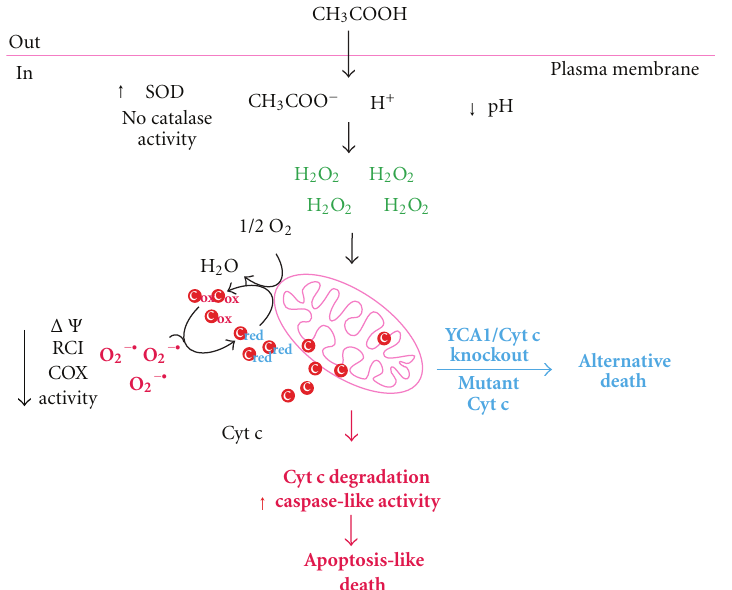
Figure 1: AA-PCD pathways. Acetic acid enters in yeast cells and dissociates into acetate and protons causing intracellular acidification. H 2 O 2 accumulates, SOD activity increases, while catalase activity is undetectable. En route to AA-PCD, cyt c is released and works as an electron donor (c red ) to mitochondrial respiratory chain and as superoxide anion (O 2 − • ) scavenger (c ox ). In a late phase, cyt c is degraded by unidentified proteases. Mitochondrial functions progressively decline with decrease in mitochondrial membrane potential ( ΔΨ ), respiratory control index (RCI) and COX activity. Caspase-like activity increases in a late phase (red lines). Alternative programmed cell death is induced by acetic acid in YCA1 and/or cyt c knockout cells or in mutant cyt c cells (blue lines).